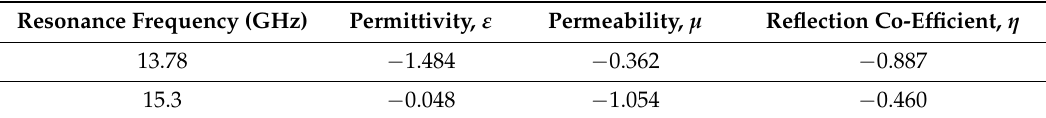
Figure 4. H-field distribution at the resonance frequency ( a ) 13.78 GHz, ( b ) 15.3 GHz of proposed MM absorber. Table 2. LHM characteristics values of proposed MM absorber at resonance.